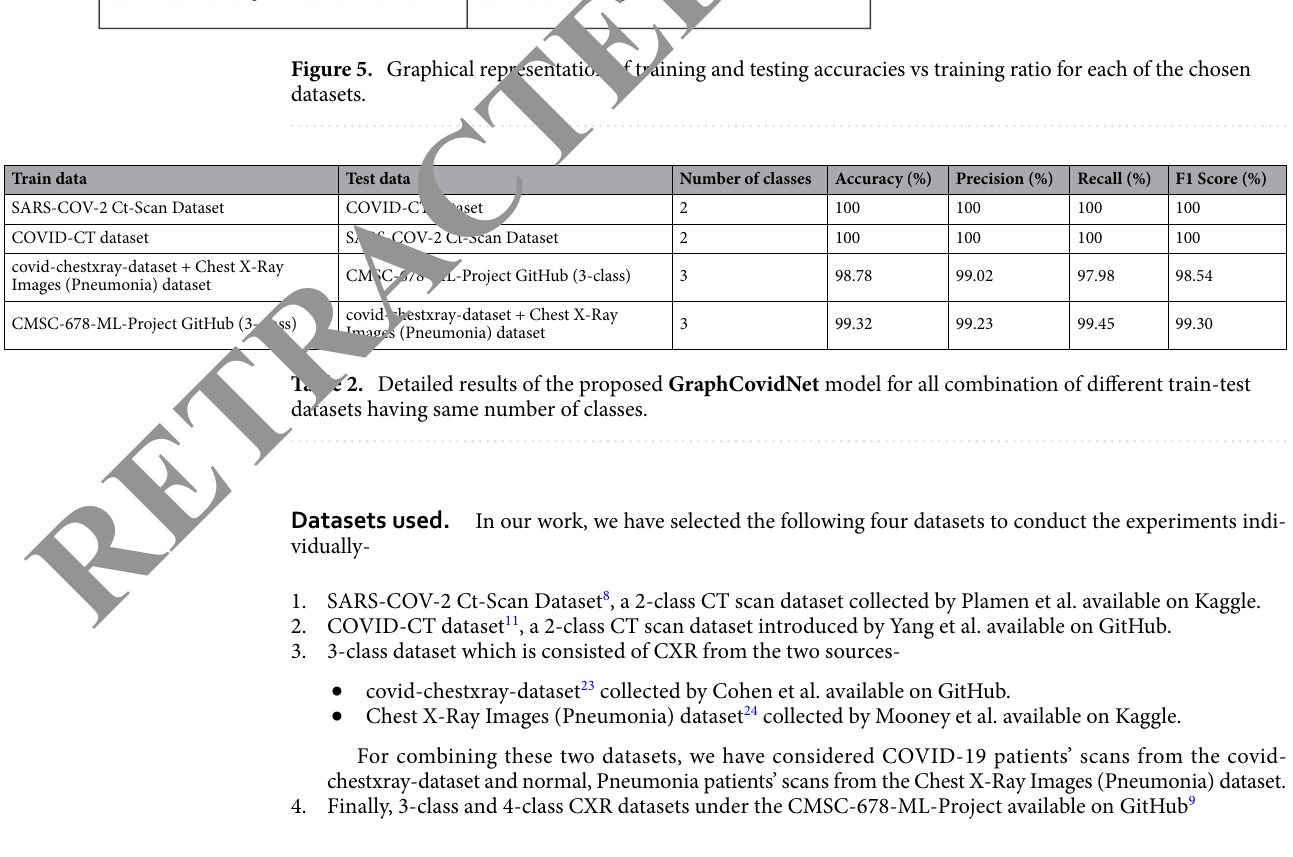
Figure 5. Graphical representation of training and testing accuracies vs training ratio for each of the chosen datasets.